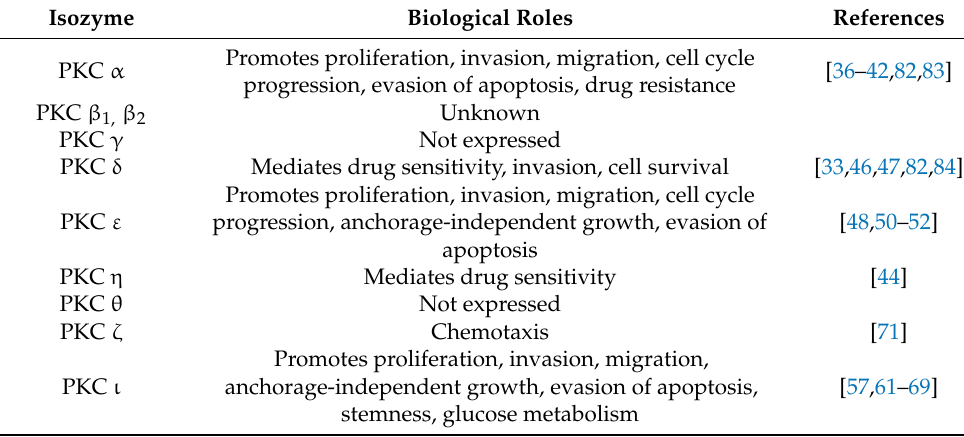
Table 1. Proposed biological roles of distinct PKC isozymes in